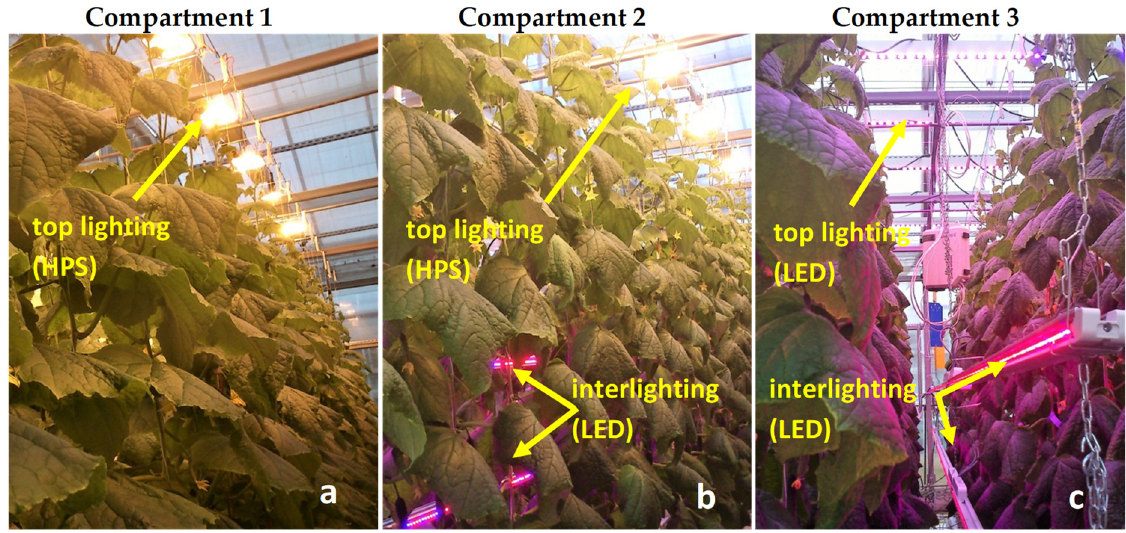
Figure 2. Experiment lighting schemes: ( a ) HPS, ( b ) HPS + LED and ( c ) LED. By measuring PAR with a Li-Cor Light meter LI-250A, quantum sensor LI-190 with all lamps on, an ~320 µ mol m − 2 s − 1 PPFD (photosynthetic photon flux density) was